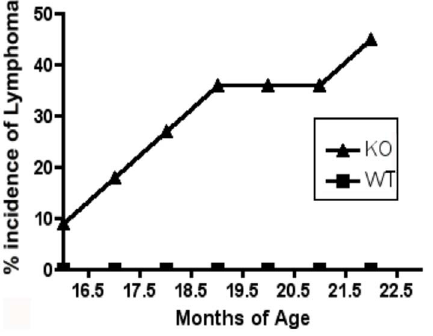
Figure 8. Incidence of lymphoma in Nfatc2 KO mice. Seven of fifteen Nfatc2 KO mice (congenic generations 6–9 from heterozygous matings) that were allowed to reach 16 to 20 months of age (denoted by triangles/KO) developed B-cell malignancies. By comparison, none of 12 wild type or Nfatc2 age-matched hemizygous littermates (denoted by squares/WT) developed